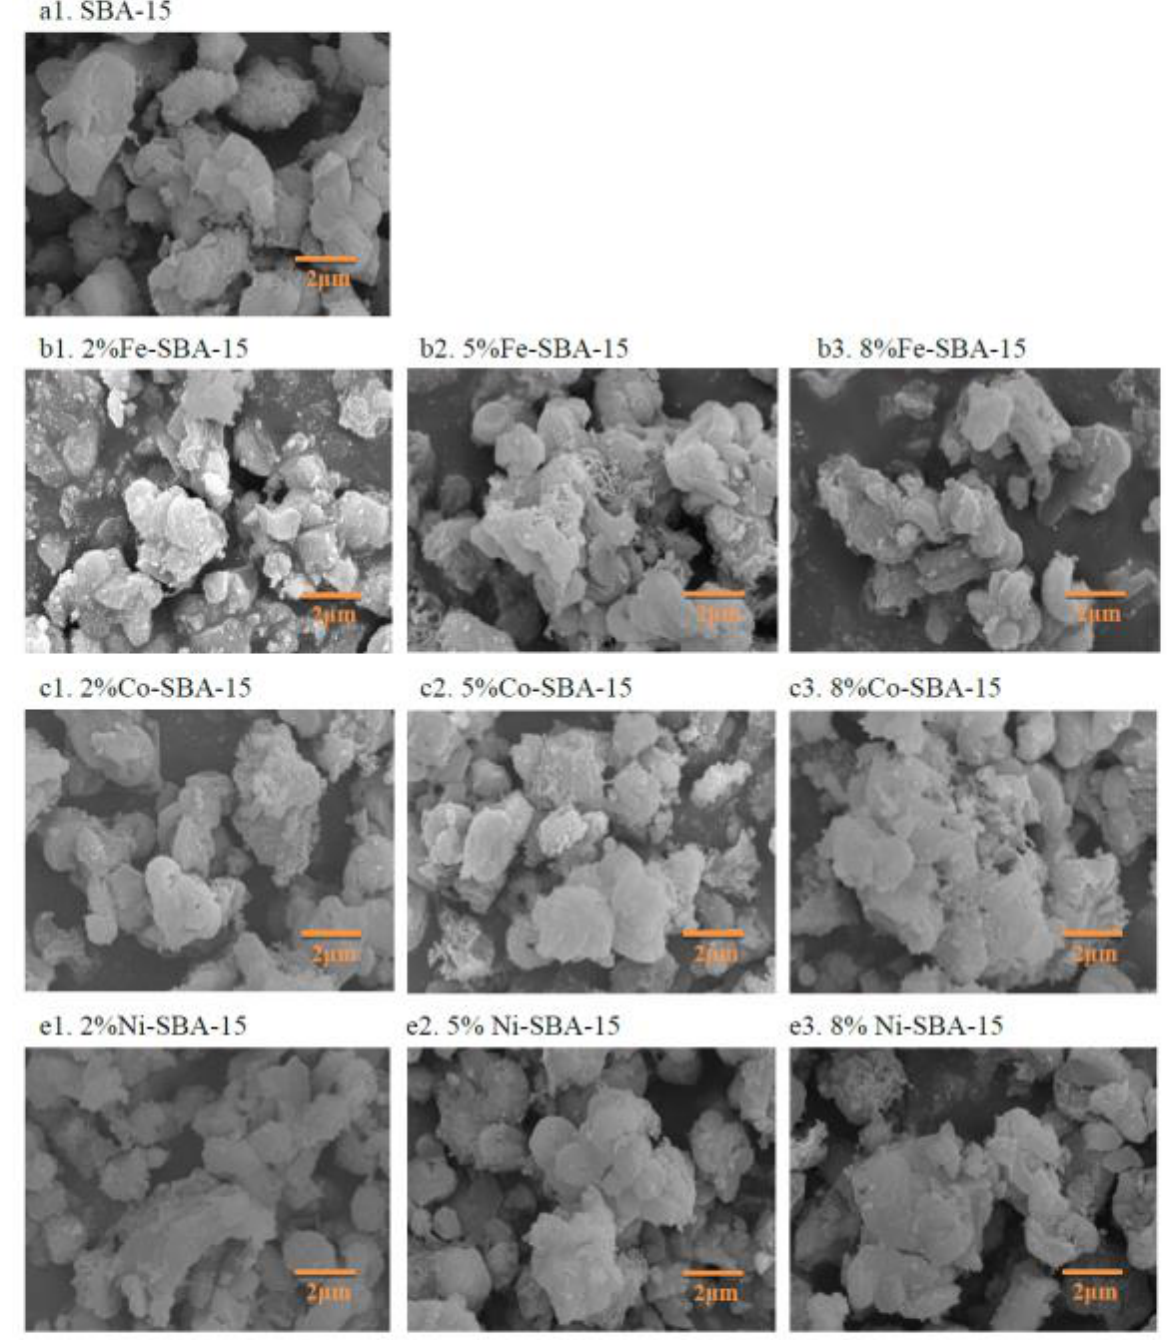
Figure 1. SEM morphology of SBA-15 and Fe-, Co-, and Ni-impregnated (2–8 wt%) SBA-15.